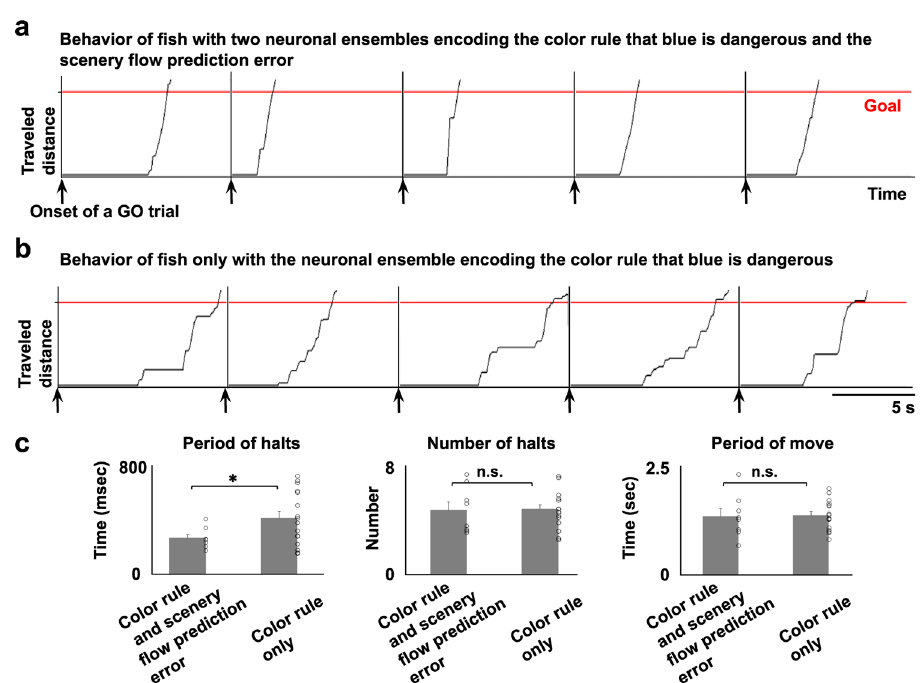
Fig. 7 Fish with the scenery fl ow prediction error ensemble swam straight toward the goal with shorter halts than fi sh with only the color rule-coding ensemble. a , b The traveled distance in fi ve successful GO trials after the establishment of behavioral learning in a fi sh with both ensembles encoding the color rule that blue is dangerous and the scenery fl ow prediction error ( a ) and a fi sh with only the ensemble encoding the color rule that blue is dangerous ( b ). The black line indicates the traveled distance. The red line indicates the goal. c Comparison of the period of halts (left panel), number of halts (middle panel), and period of movement (right panel) between two groups. The number of fi sh which has color rule-coding and putative SFPE ensembles is 8 and that of fi sh which has only color rule-coding ensemble is 16. Columns and error bars: mean ± SEM. Each circle indicates the value in each fi sh. Left: * P = 0.028 (Cohen ’ s d = 0.978302). Middle: P = 0.455. Right: P = 0.457. One-tailed unpaired t -test, n.s., not signi fi